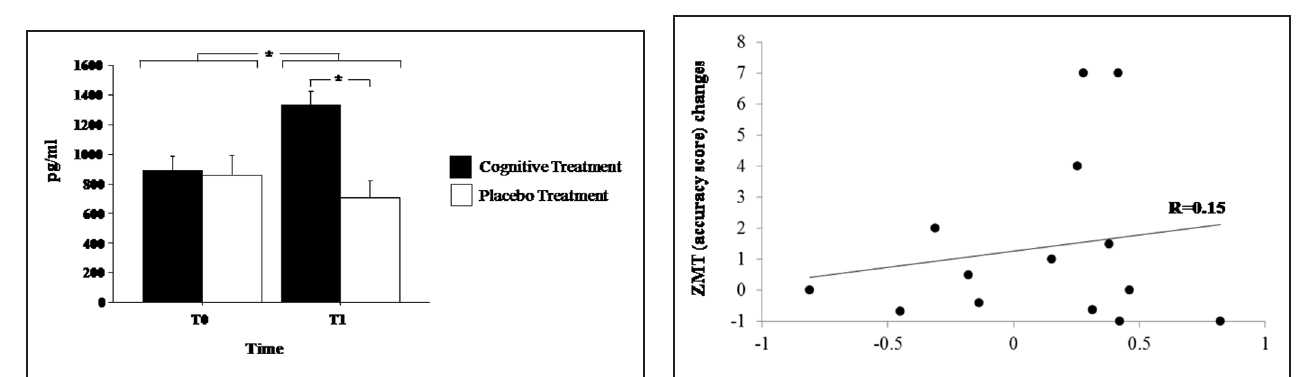
FIGURE 1 | Brain-derived neurotrophic factor (BDNF) serum levels in Parkinson’s disease patients before (T0) and after (T1) the cognitive rehabilitation protocol and placebo treatment. Data are the mean ± SEM. Values are expressed in pg/ml. Asterisk ( ∗ ) indicates significant difference between the groups. ∗ p < 0.05. Map